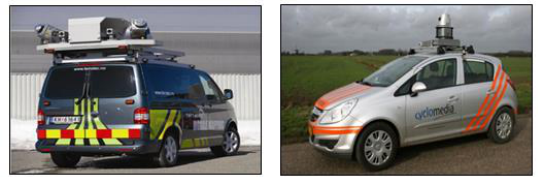
Figure 1: Left: Optech Lynx Mobile Mapper system installed on a vehicle. Right: Cyclomedia mobile mapping system Cyclomedia Technology B.V. (2010); Applanix (2014).